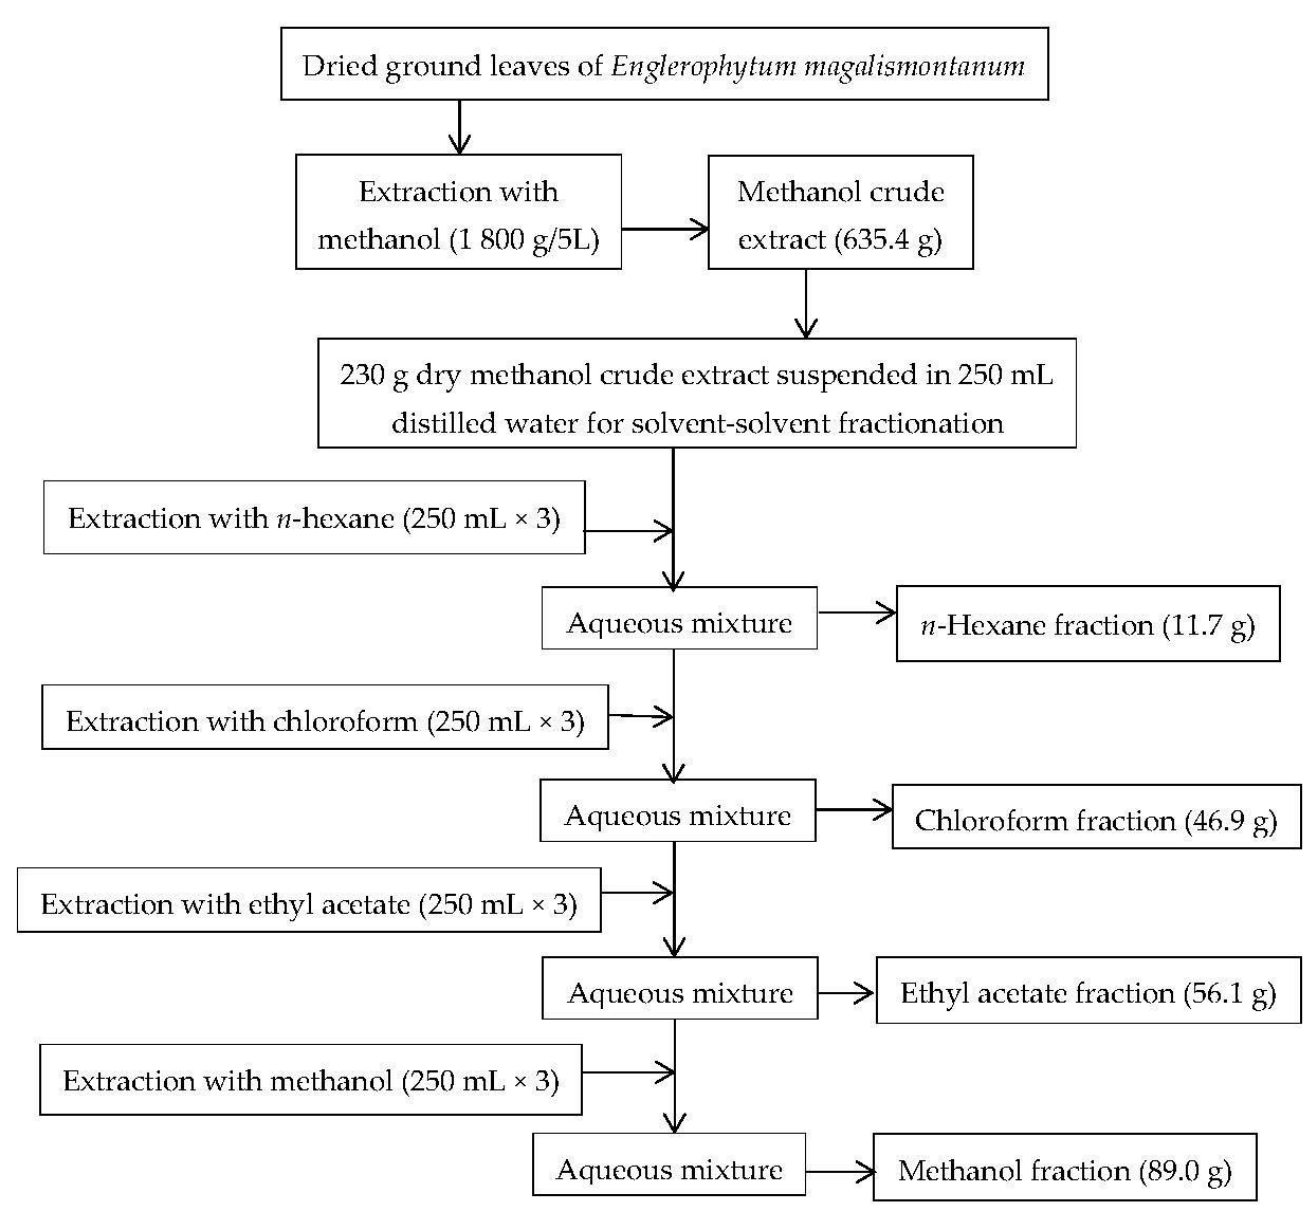
Figure 7. Schematic diagram for the extraction and solvent-solvent fractionation of methanol crude leaf extract.